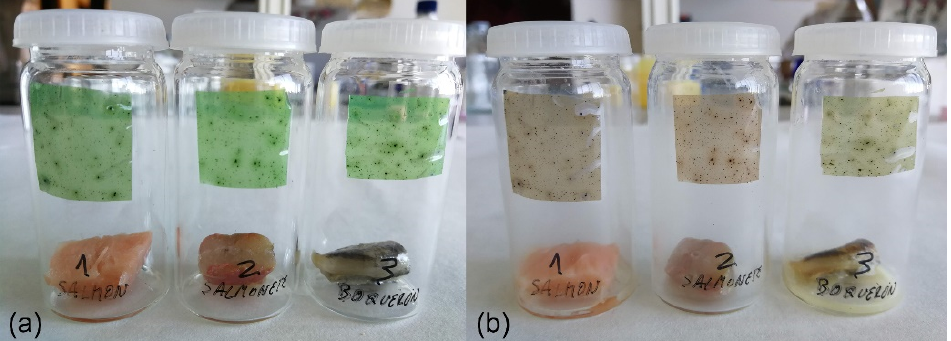
Figure 7. Sealed glass vials containing PCN-224/PDMS films and fish left to decompose. Left to right in both panels: Atlantic salmon (Salmo salar) , Red mullet (Mullus barbatus ), and European anchovy ( Engraulis encrasicolus) . ( a ) Initial status with fresh fish. ( b ) After six days of natural decomposition of fish at room temperature.